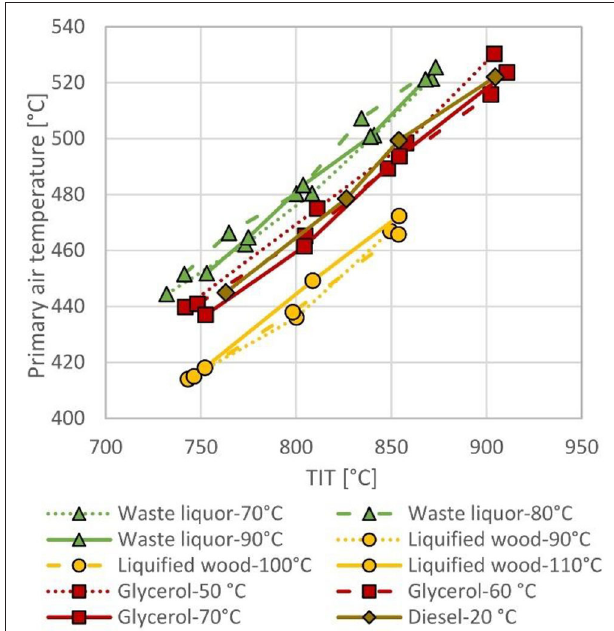
FIGURE 8 | Primary air temperatures.